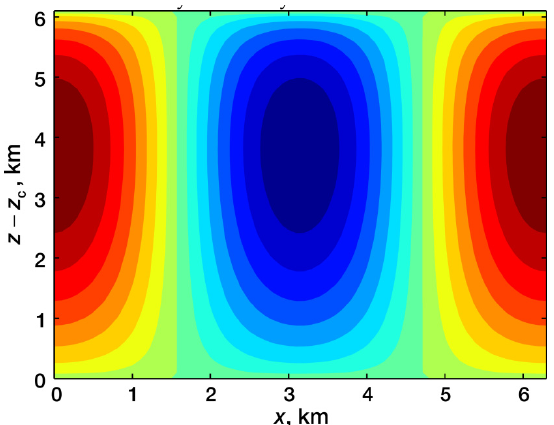
Figure 1. Stream function at b = 10 ´ 6 m ´ 1 , ∆ c T = 0.5 ˝ C, ∆ c s = 0, ∆ γ mac = 5 ˆ 10 ´ 4 ˝ C/m, = −1.6 × 10 (cid:2879)(cid:2874) m (cid:2879)(cid:2869) . k = 10 –3 m –1 , d(cid:1871) (cid:2923) d(cid:1878)⁄ | (cid:3053)(cid:2880)(cid:3053) (cid:3161) ε = 3 ˆ 10 ´ 7 ˝ C/m 2 , k = 10 ´ 3 m ´ 1 , d s m { d z | “ ´ 1.6 ˆ 10 ´ 6 m ´ 1 z “ z c